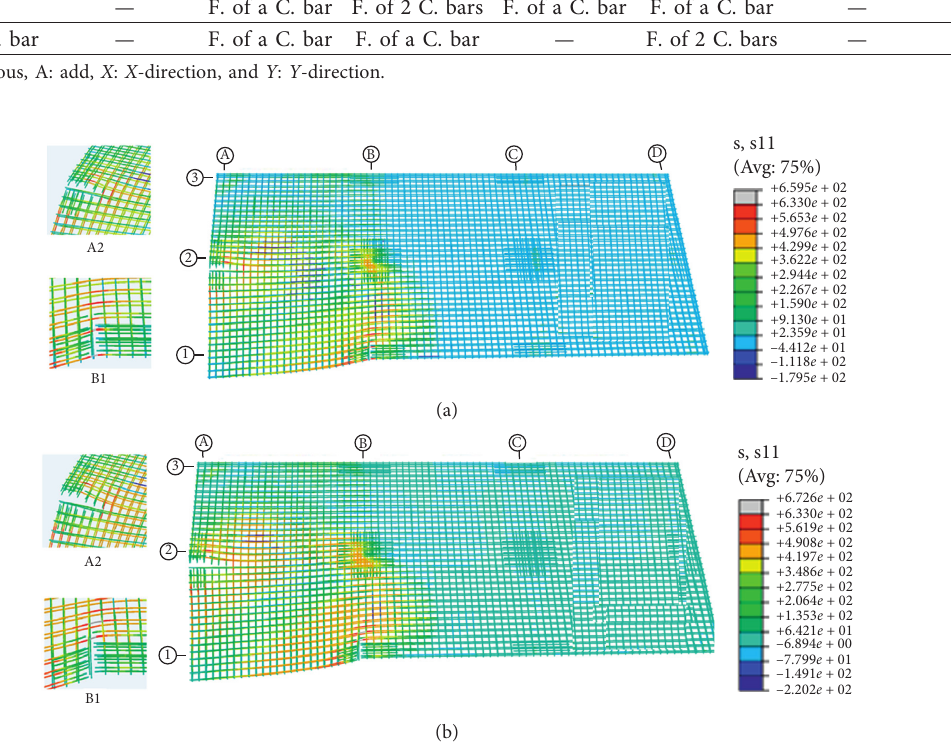
Figure 7: Stress state of the slab bars in model RC at station D (a) and station E